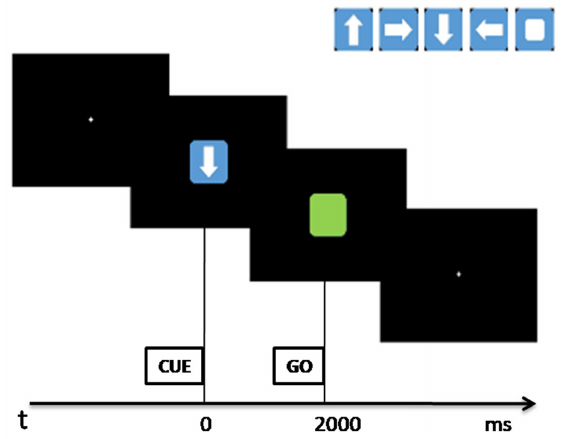
Figure 1. Typical trial of the experimental task: at T 0 the cue stimulus appears; after 2000 ms, the go stimulus is presented. At the go stimulus, the subject has to respond as fast as possible, clicking the stimulus seen at the cue. In the top right of the fi gure the set of directional and non ‐ directional kind of stimuli are reported. At the cue appearance, the participant was trained to only think about the direction presented by the stimulus, holding the index fi nger over the numeric keypad. Based on the direction of the cue stimulus, the subject had to press the numeric keypad at the cor ‐ responding key when the go stimulus appeared: “4” for left, “8” for up, “6” for right, “2” for down. In case of the white square appearing, the subject was free to choose a direction to think about, so to press the key indicating the chosen direction at go stimulus ap ‐ pearing. Each subject was instructed to maintain a fi xed central fi nger position above the keys and to move exclusively to respond by pressing the correct key at the go stimulus appearance as soon as possible. The reaction times (RTs) to the go stimulus were rec ‐ orded. In total, 400 pseudorandomised cues were presented (320 DS, 80 nDS) on a 24 ‐ inch monitor. The entire task was built using Presentation ® software (Neurobehavioral Sys ‐ tems). 2.3. Data Recordings and Pre ‐ processing Analysis Electroencephalographic (EEG) signals were continuously recorded during the task from 64 electrodes (BrainAmp Brain Products) located in agreement with the Interna ‐ tional 10–20 scheme. Two distinct channels, horizontal and vertical EOGs, were used to check eye blinking. Impedance was maintained under the threshold of 5 k Ω and the sampling rate frequency was con fi gured at 1000 Hz. The data were analysed in MATLAB, utilizing custom ‐ made scripts built on the basis of EEGLAB functions (Swar tz Center for Computational Neurosciences, La Jolla, CA, USA) [35,36]. In particular, the EEG data were resampled at 512 Hz and a band ‐ pass fi nite impulse response (FIR) fi lter from 0.2 to 30 Hz was applied. EEG data were divided into single epochs for every single type of stimulus (S1, S2, S3, S4, S5, which refers to left, up, right, and down arrows and white square, respectively) of 5 s duration, from − 1.5 s to +3.5 s around the onset of the cue stimulus. An EEG expert eliminated the main artifacts that appeared in the EEG record ‐ ings (such as eye movements, cardiac activity and scalp muscle contraction) initially by a visual inspection and then using Infomax procedure of Independent Component Analy ‐